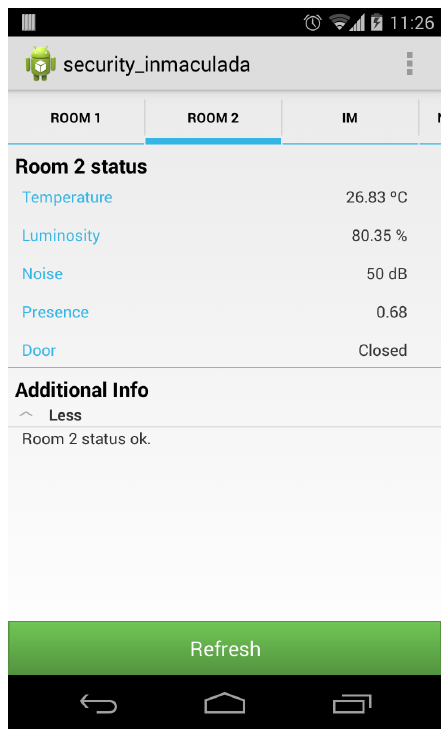
Figure 17. Screen shot of the monitoring info of a Type 2 room in our museum, which summarizes the data provided by sensing devices deployed in Exhibit Room 2